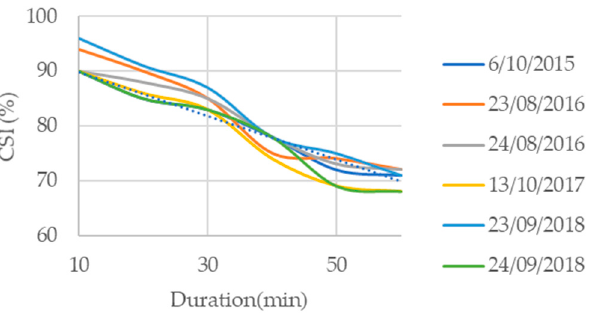
Figure 10. The result of the RTFlood system displayed on a website.